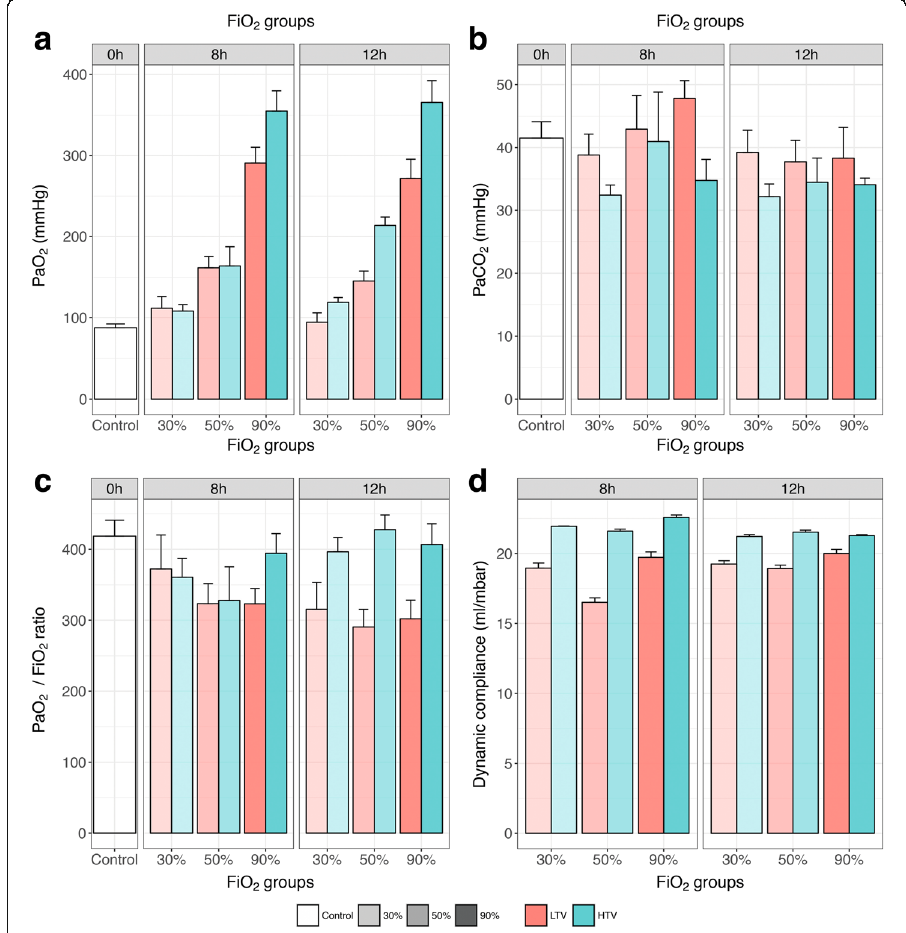
Fig. 1 Arterial oxygenation and ventilation parameters. Data are means ± SEM. Arterial oxygenation in carotid blood ( a , upper left panel), arterial carbon dioxide in carotid blood ( b , upper right panel), PaO 2 /FiO 2 ratio ( c , lower left panel), and dynamic compliance ( d , lower right panel). Facets within the panels represent mechanical ventilation time. Different colors represent different tidal volume groups, and different transparency levels represent different FiO 2 groups. 0h no mechanical ventilation time, control group; 8h 8 h of mechanical ventilation, 12h 12 h of mechanical ventilation, LTV low tidal volumes, HTV high tidal volumes. Dynamic lung compliance (tidal volume size/(peak inspiratory pressure − PEEP) was measured hourly. PaO 2 and PaCO 2 were measured once in the arterial blood gas sample taken from the carotid artery at the end of the